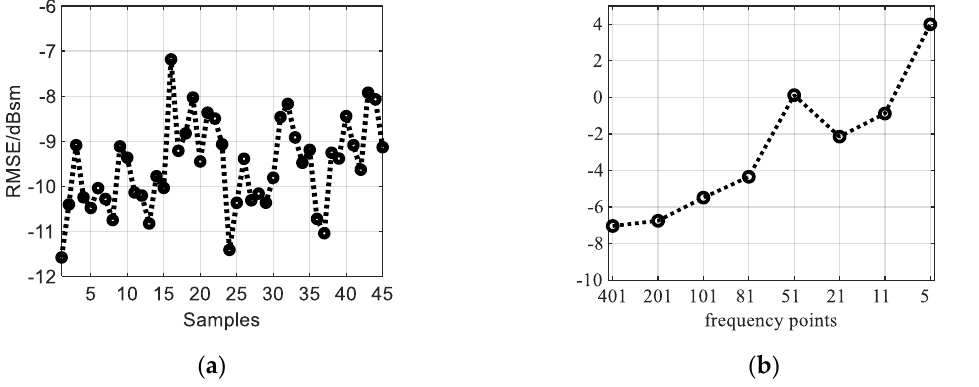
Figure 8. Test error ( a ) the RMSE of different sample output from neural network. ( b ) The RMSE of “image-based” NFFFT result (only the center frequency) respect to different frequency points.